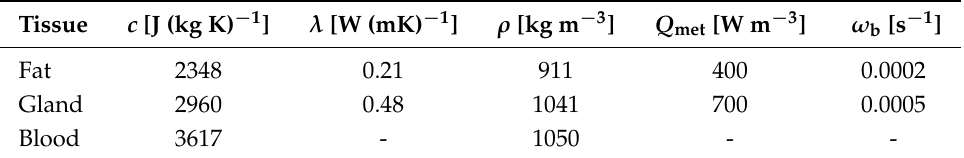
Table 2. Thermo-physical properties of the biological domains that were used in the simulation. The values were obtained from Refs.